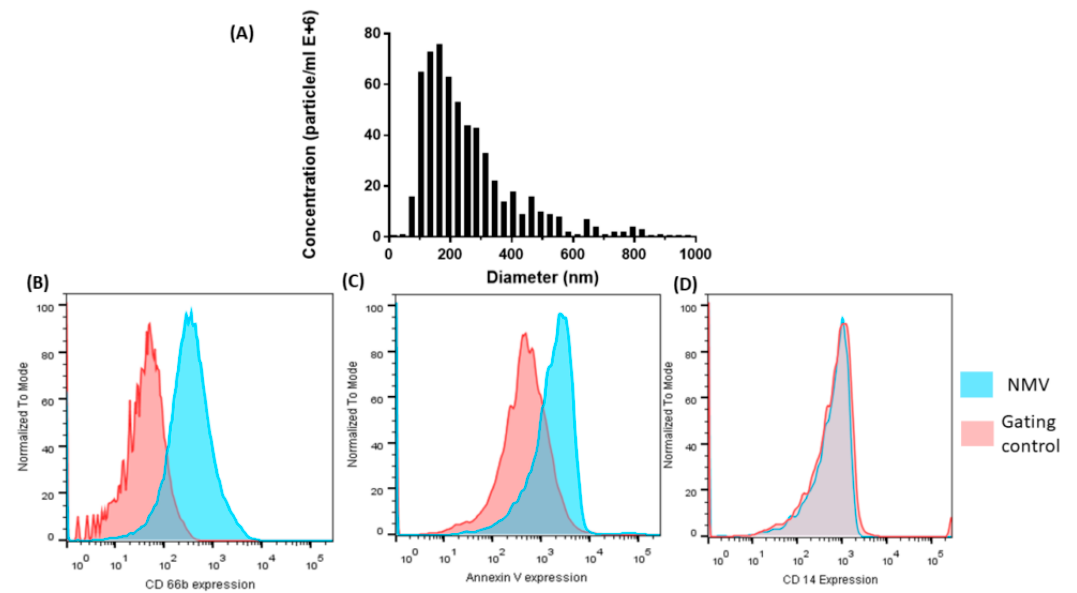
Figure 1. Characterization of neutrophil-derived microvesicles (NMV) internalization by hCMEC / D3. ( A ) NMV size distribution were measured using ZetaView nanoparticle tracking analysis. NMV express ( B ) the neutrophil surface antigen CD66b and ( C ) annexin V, but not ( D ) CD14 (monocytes), as